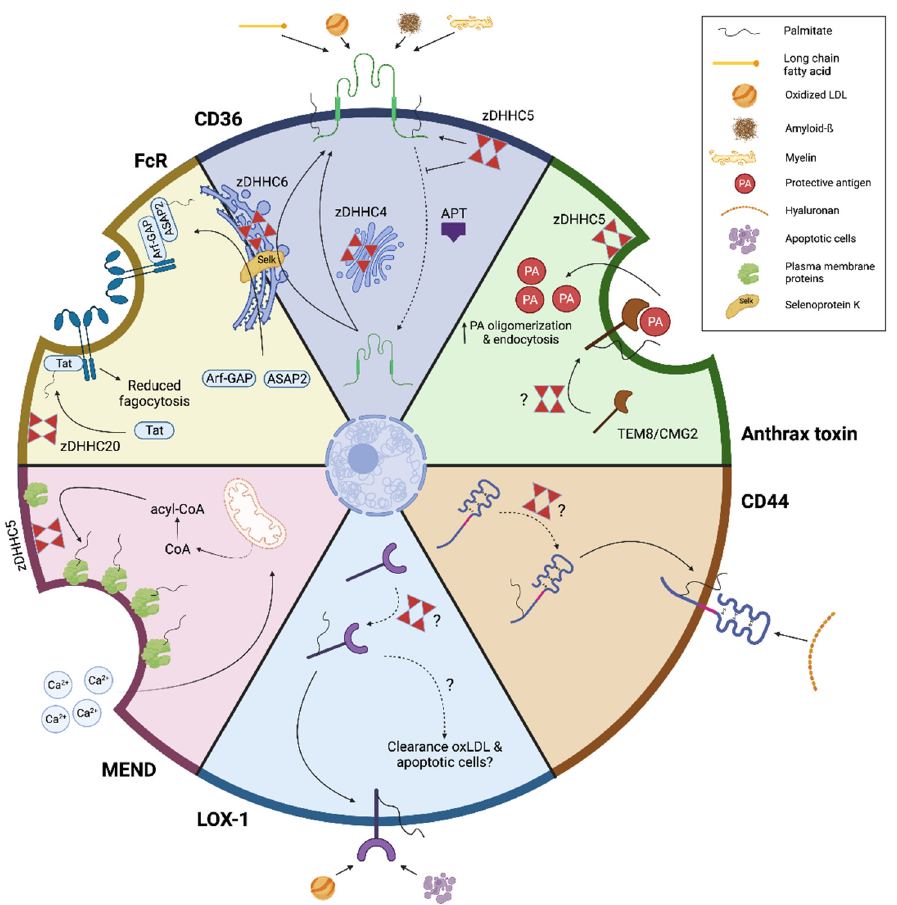
Figure 2. S-palmitoylation controls macrophage endocytosis. Ample evidence indicates that many endocytic receptors on macrophages require S-palmitoylation for their sequestration in lipid rafts and function. First, Fc receptor-mediated endocytosis relies on S-palmitoylation. Here, zDHHC6/SelK-mediated S-palmitoylation of the scaffolding protein ASAP2 was found to inhibit FC receptor-mediated endocytosis. Similar, zDHHC20-mediated S-palmitoylation of the viral toxin Tat was found to reduce FcR-mediated phagocytosis during HIV-1 infections. Second, the intracellular transport, plasma membrane localization, and function of the scavenger receptor CD36 depend on palmitoylation by zDHHC4–6 and Selenoprotein K (SelK). Third, the anthrax toxin produced by Bacillus anthracis hijacks the palmitoylation machinery to affect macrophage endocytosis. Here, S-palmitoylation of plasma membrane receptors TEM8 and CMG2, as well as zDHHC5-mediated S-palmitoylation of the proteases furin and PC7, was found to affect raft association, oligomerization, and endocytosis of protective antigen (PA), a subunit of anthrax toxin. Fourth, few studies indicate that the endocytic receptors CD44 and lectin-like oxLDL receptor-1 (LOX-1) rely on palmitoylation for proper plasma membrane distribution. The zDHHCs and acylprotein thioesterases (APTs), as well as the functional impact CD44 and LOX-1 S-palmitoylation, remain to be determined. Finally, S-palmitoylation triggers a process coined massive endocytosis (MEND) through zDHHC5-mediated S-palmitoylation of plasma membrane proteins in lipid rafts. Figure created with BioRender.com (accessed on 9 January